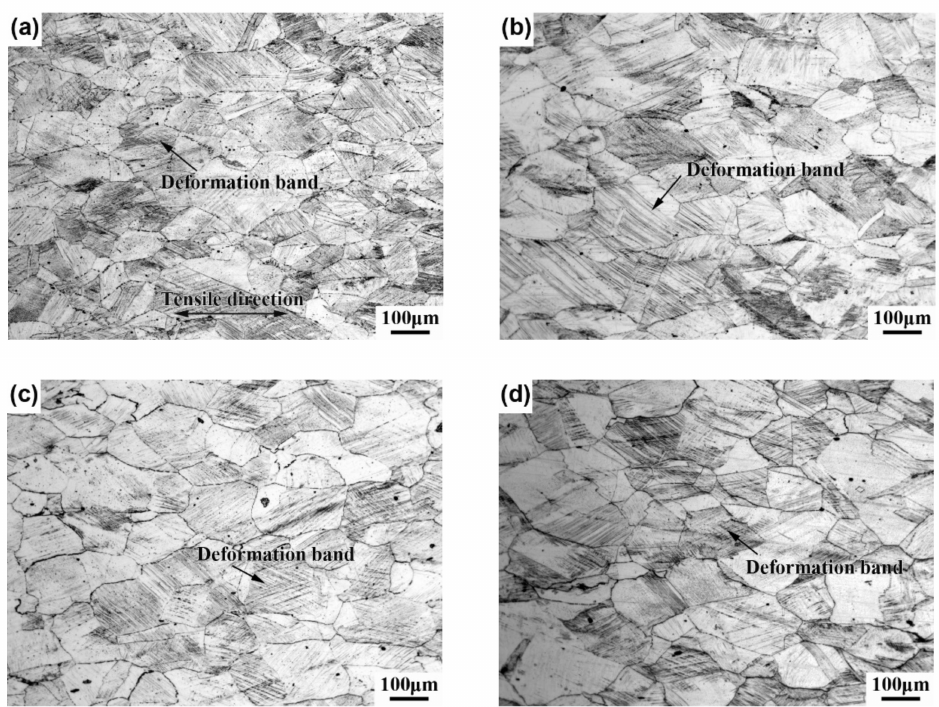
Figure 3. Optical images of test steels with a tension deformation strain of 0.2. ( a ) 80Mn11;